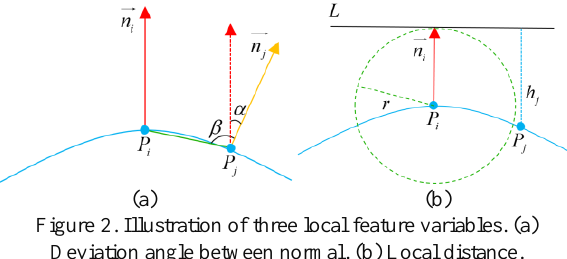
occurred, indicating that the probability of one point in generated by m- th GMM component